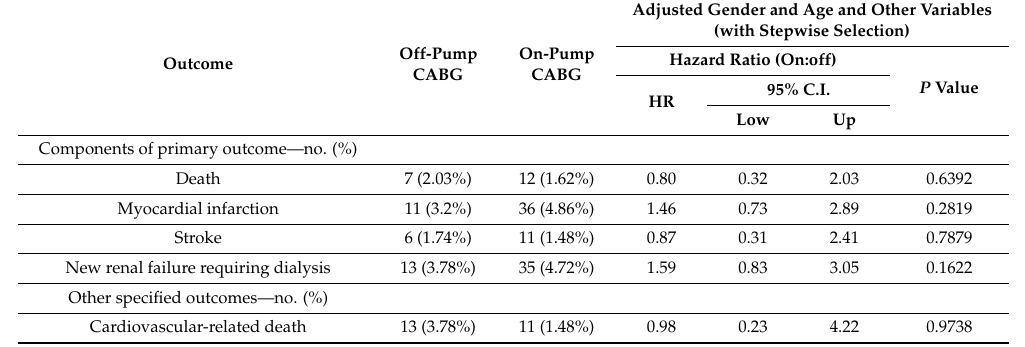
Table 3. Outcomes at 1 year.